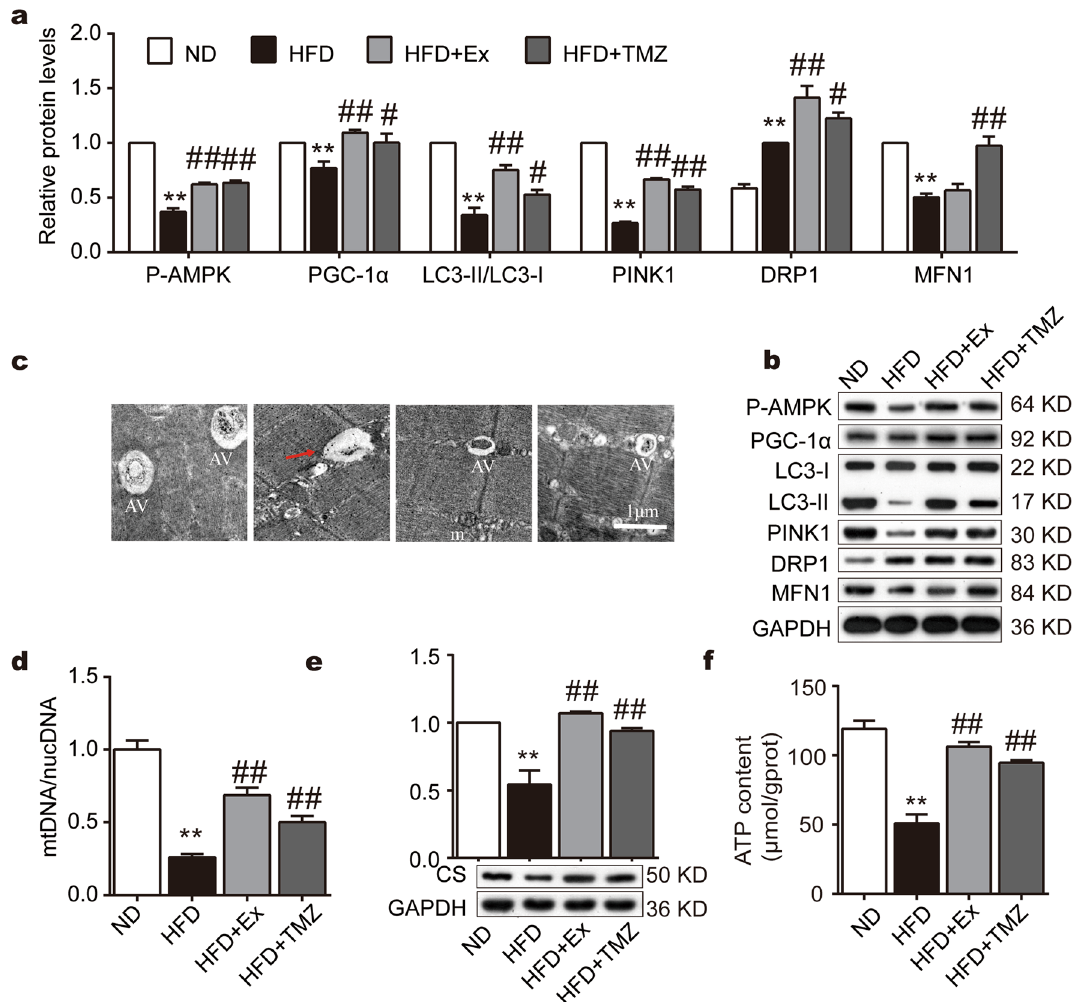
Figure 4. Comparative to exercise, TMZ regulates MQC and improves mitochondrial functions in HFD mice. ( a , b ) P-AMPK, PGC-1α, LC3II/LC3I, PINK1, MFN1, and DRP1 protein expressions were determined by Western blot. ( c ) Transmission electron microscope observation of mouse skeletal muscle tissue with 1 μm scale. AV autophagic vacuole, m mitochondria. ( d ) Mitochondrial DNA/nuclear DNA was determined by PCR. € CS protein expression was determined by Western blot. ( f ) ATP content were measured. *, ** represented p < 0.05, p < 0.01 in comparison with ND group, respectively; # , ## represented p < 0.05, p < 0.01 in comparison with HFD group,